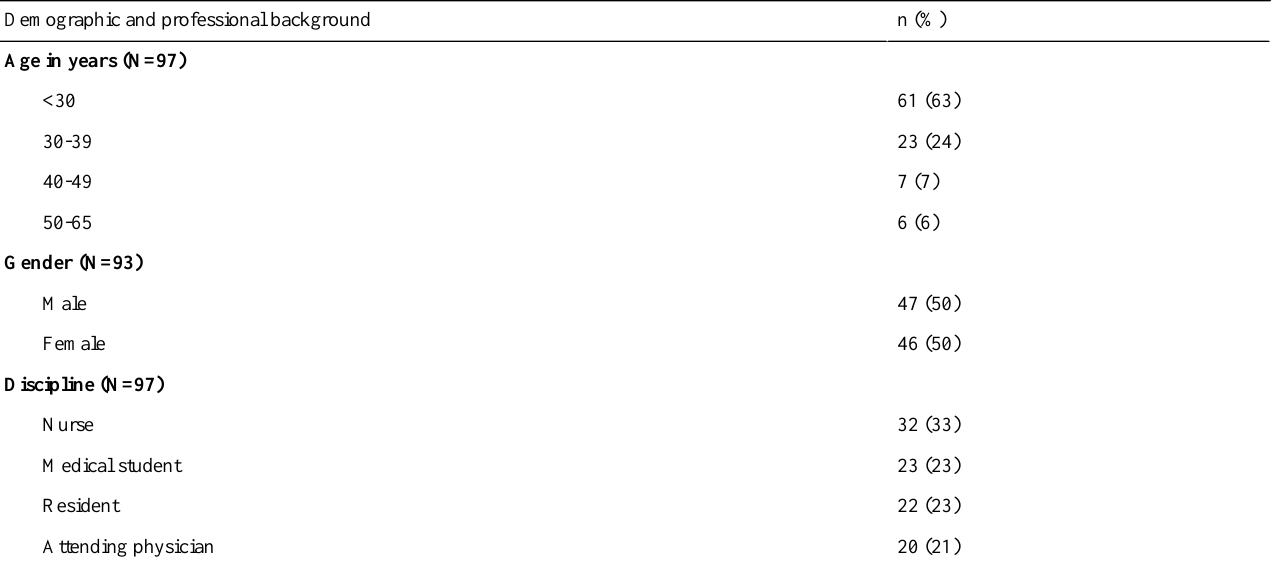
Table 1. Distribution of the demographic and professional background.